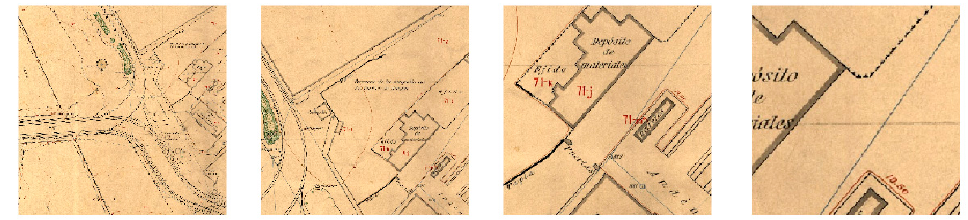
Figure 6. A detail of the former Aragón Railway Station at zoom levels 17 (left) to 20 (right). Note the increasing detail of the map elements in upper levels.